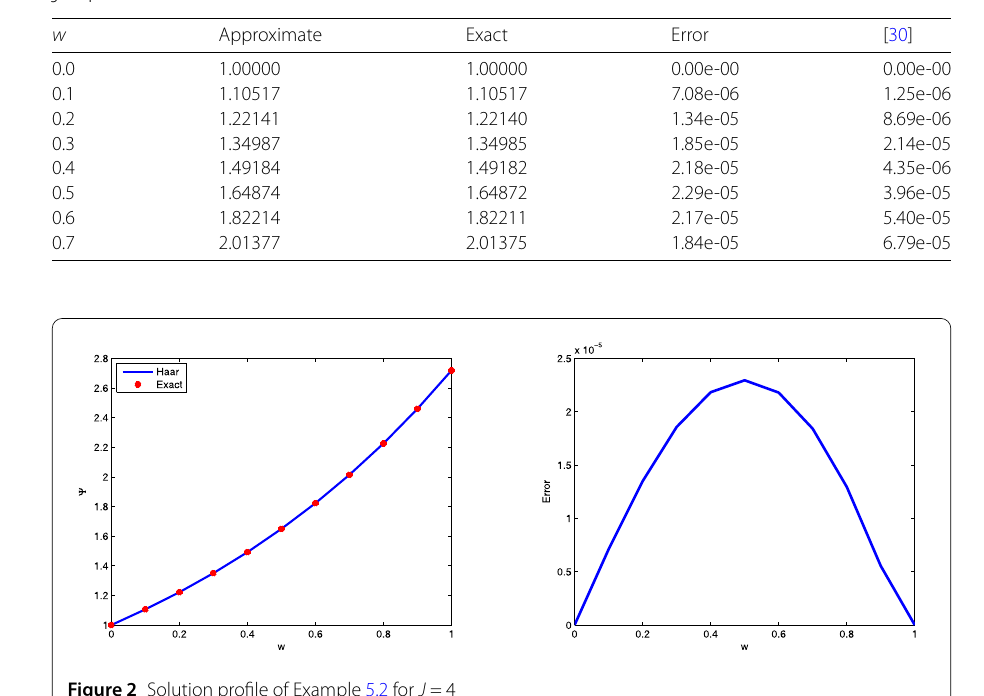
Equation (42) contains a total of 2 M equations in 2 M unknowns. The system has been solved for unknowns with initial approximation (cid:7) 0 ( w ) = 1. After calculation of b i , ap- proximate solutions have been calculated from Eq. (38) for σ = 0. In Table 2 the computed solutions are compared with the exact solution and the results given in [30]. In the same table we also recorded the absolute error. From the table one can see that the proposed method has comparatively good results. In Fig. 2 the plots of exact, approximate solutions and absolute errors are presented. The figure shows that exact and approximate solutions premise